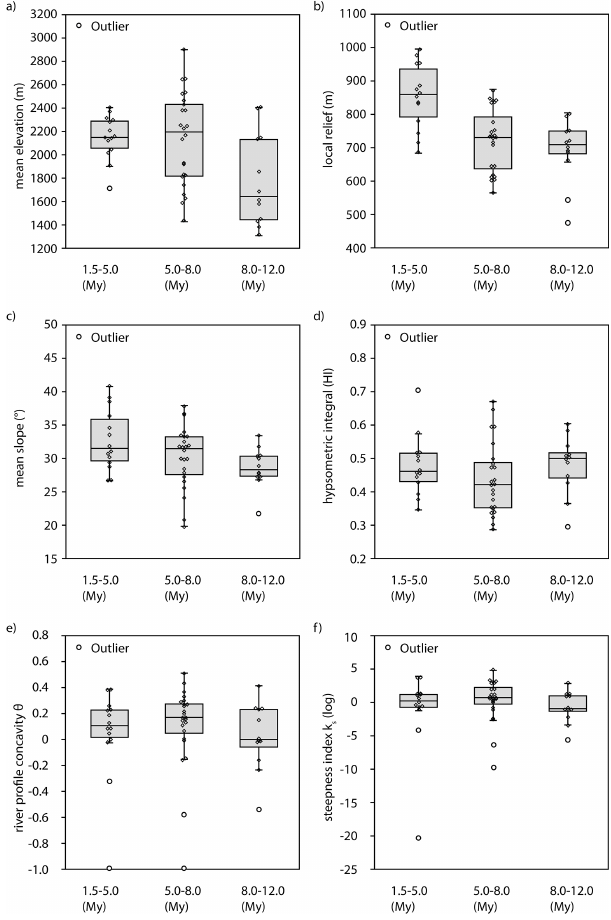
Figure 8. Boxplots of the topographic variables grouped according to the apatite fission-track ages (Vernon et al., 2008), which give long-term uplift information. The boxes represent the areas in which 50% of the data plot (first and third quartile). The line in the mid- dle is the median of the data. The whiskers mark the maximal and minimal value, and outliers are represented by white